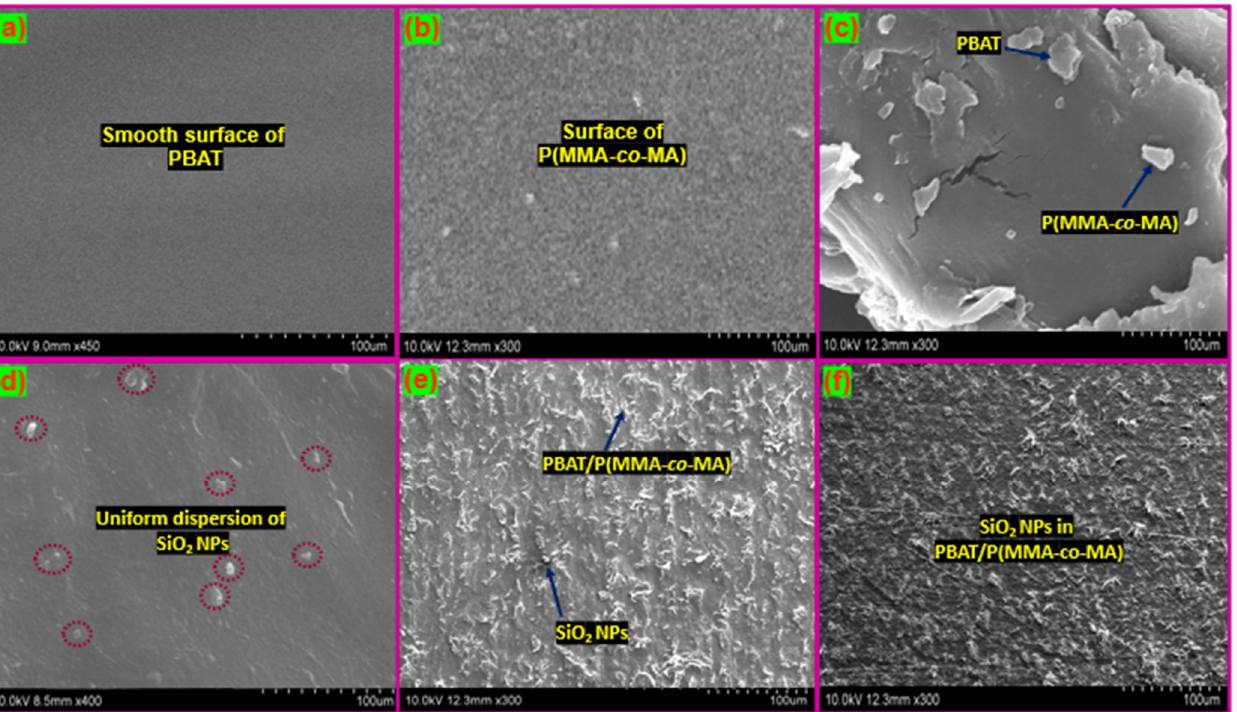
Figure 6. SEM images of the surfaces of PBAT/P(MMA- co -MA) blends and their composites: ( a ) PBAT, ( b ) P(MMA- co -MA), ( c ) PBAT/P(MMA- co -MA) blends, ( d ) 1.0, ( e ) 3.0, and ( f ) 5.0 wt.% of SiO 2 NPs.